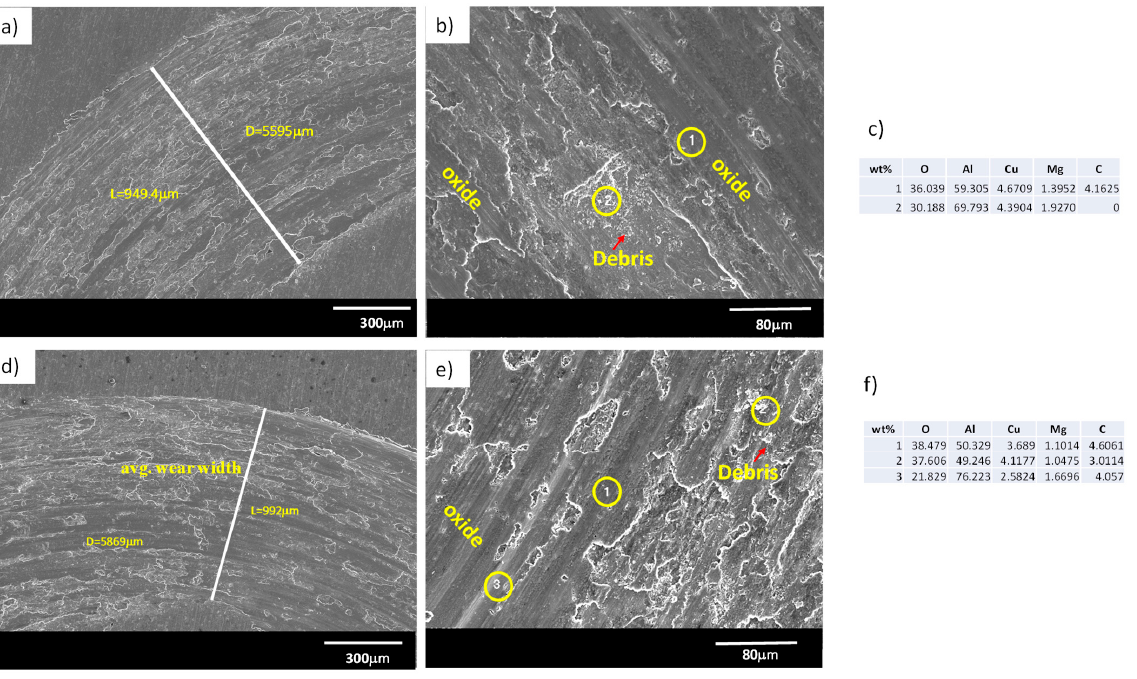
Figure 7. Wear scars of the Al-2024 alloy with the: ( a , b ) steel and ( d , e ) ceramic ball counterparts and EDX analysis of yellow marks of figure 7b (c) and figure 7e (f).